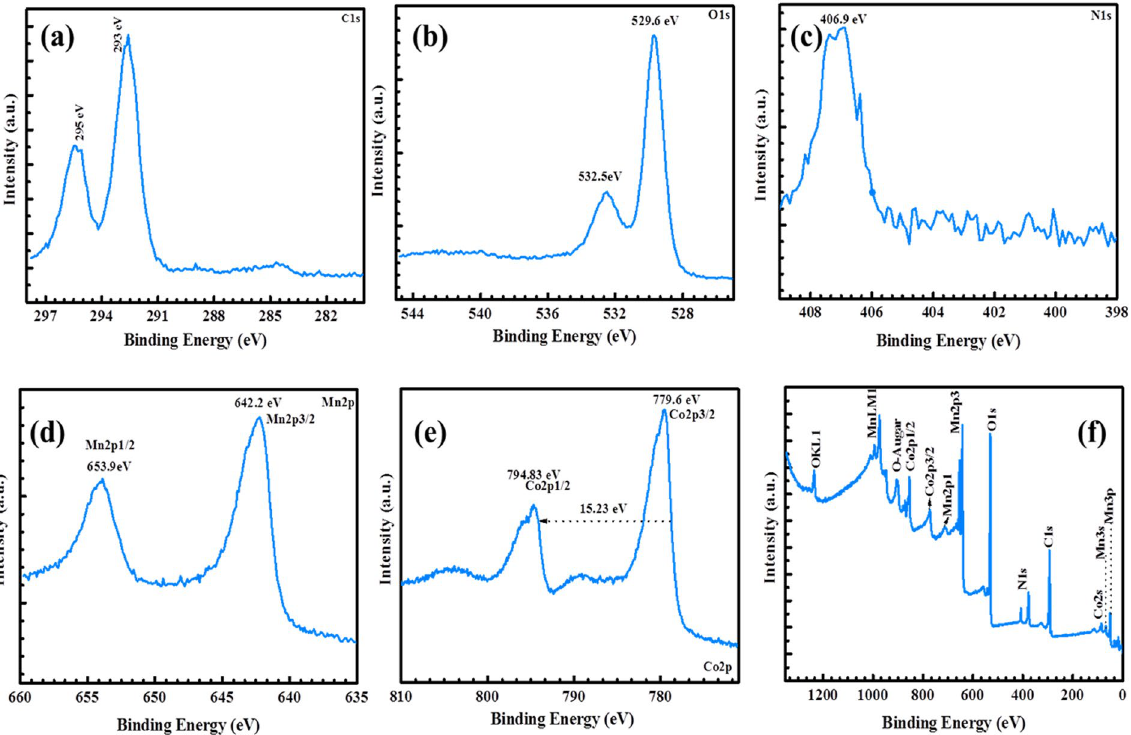
Figure 3. XPS results ( a ) C1s (b) O1s ( c ) N1s ( d ) Mn 2p ( e ) Co2p energy levels of hybrid